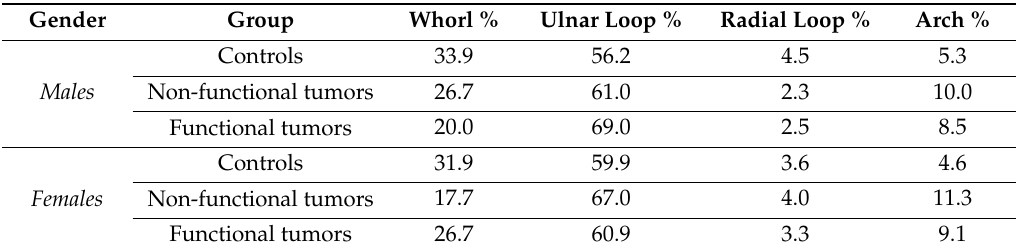
Table 3. Relative distribution of qualitative dermatoglyphic traits (fingertip patterns) in groups with tumors (functional and non-functional) and controls.